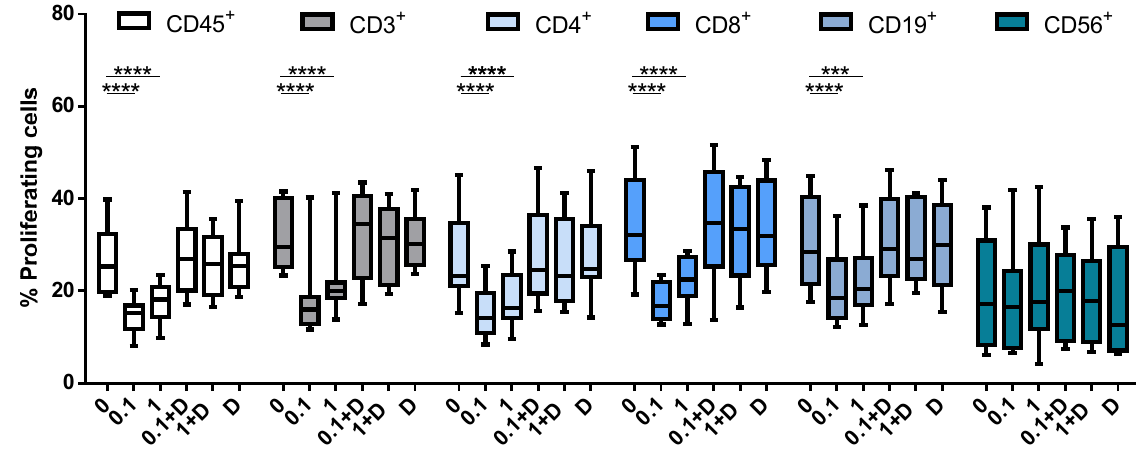
Figure 2. Box plots showing the percentage of proliferating cells in CFSE-stained PBMCs. Cells were stimulated with PHA at 0.25 μ g/mL for 96 h. No cladribine, cladribine at 0.1 μ M or 1 μ M in the presence or absence of 250 μ M of deoxycytidine was added for the last 48 h. Percentages of gated CD45 + , CD3 + , CD4 + , CD8 + , CD19 + and CD56 + that lost basal CFSE basal expression are shown. The gating strategy for this experiment is shown in Supplementary Figure S1. One-way ANOVA with repeated measures followed by Dunnett’s multiple comparisons test was performed comparing every mean value to a control mean (0 group). *** p -value ˂ 0.001, **** p -value ˂ 0.0001. ( N = 10). Cladribine concentrations ( μ M) are plotted on the x axis. D: deoxycytidine.